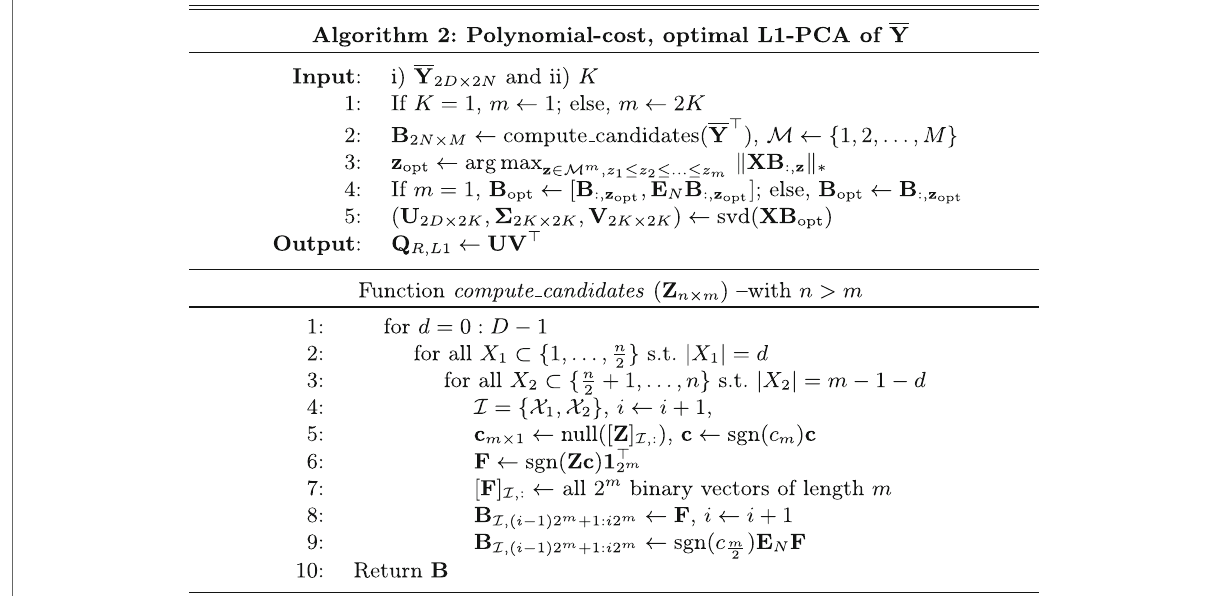
Fig. 3 Algorithm for optimal computation of the 2 K L1-PCs of the rank-2 D data matrix Y 2 D × 2 N with polynomial (w.r.t. N ) asymptotic complexity (cid:9) (cid:12) O N 4 DK − m + 1 ( m = 1 for K = 1; m = 2 K , for K > 1)